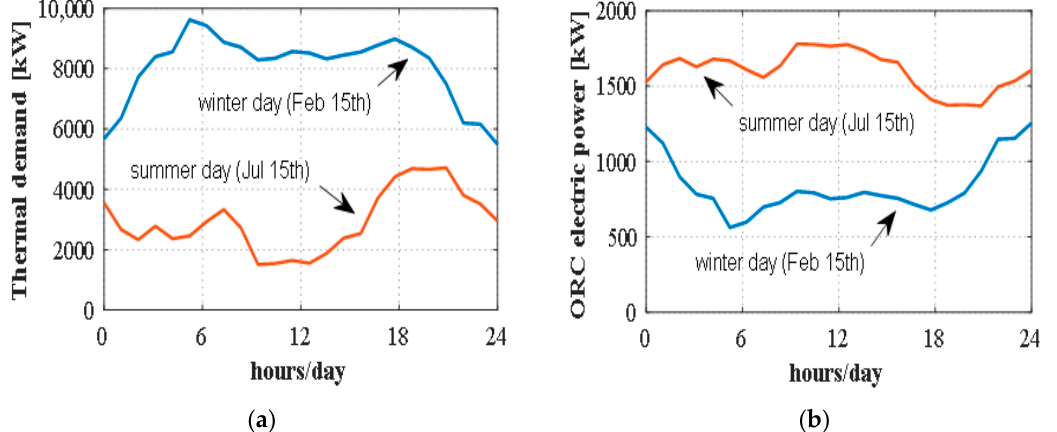
Figure A2. Daily profile of Thermal demand and ORC net electric power output for two representative days: ( a ) 15th of February; ( b ) 15th of July.